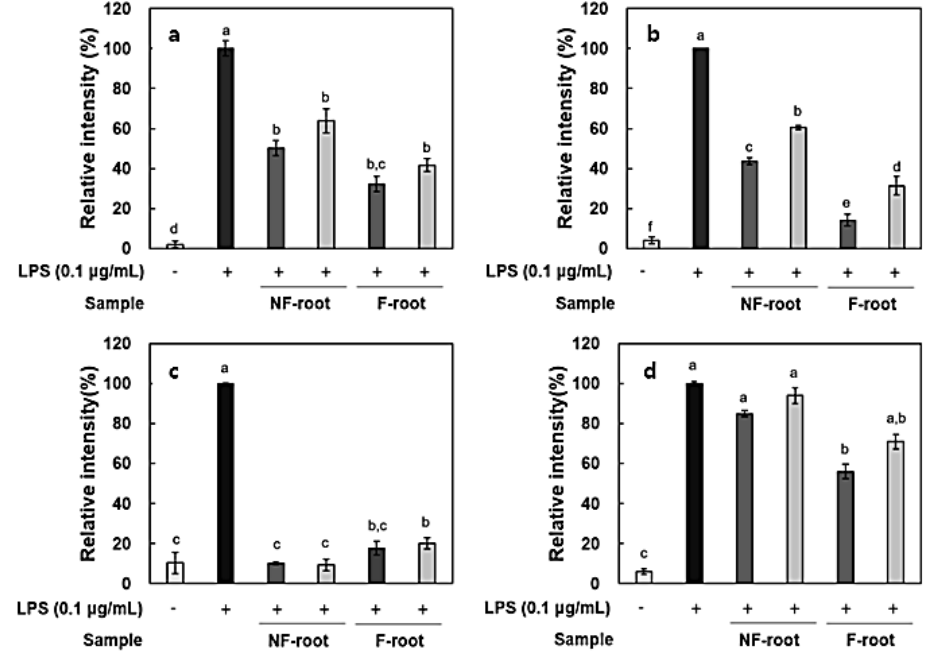
Figure 3. Relative expression of inflammatory mediators in lipopolysaccharide (LPS)-stimulated RAW 264.7 cells treated with hydroponic ginseng root. ( a ), Inducible nitric oxide synthase (iNOS); ( b ), tumor necrosis factor- α ( TNF- α ); ( c ), interleukin-6 (IL-6); and ( d ), interleukin- 1β ( IL- 1β ) . 200 μg/mL; 100 μg/mL. NF, non -fermented; F, fermented. Values are means ± standard deviation of triplicate experiments. Different letters in same column indicate significant differences as determined by Duncan’s multiple range tests ( p < 0.05). Different letters (a, b, c, and d) represent significant differences among samples.